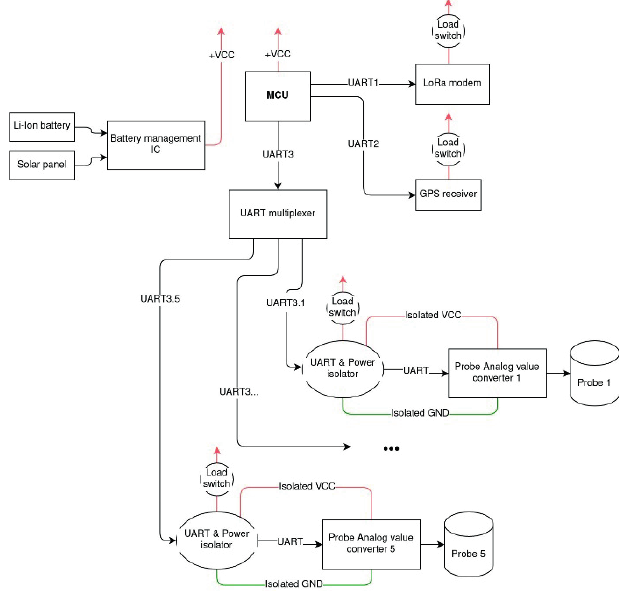
Fig. 1. The block diagram of the wireless sensor nodes. The node is powered by two 18650-type Li-Ion batteries and a small single-cell solar panel through a BQ25570 power